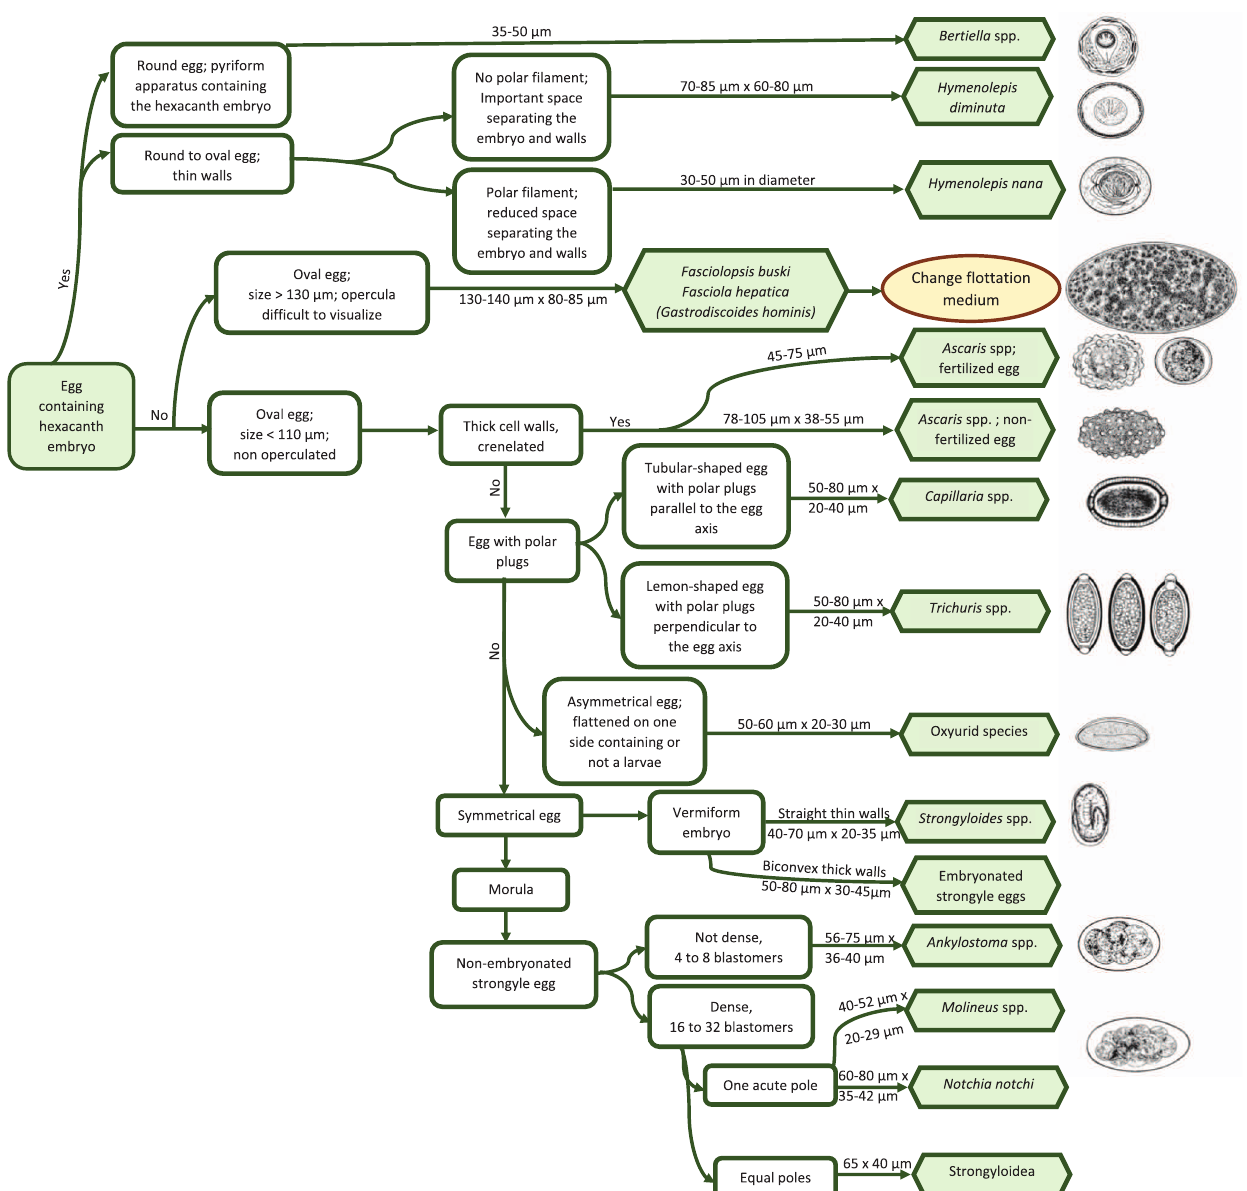
Figure 5. Decision-making tree for the diagnosis of helminths in non-human